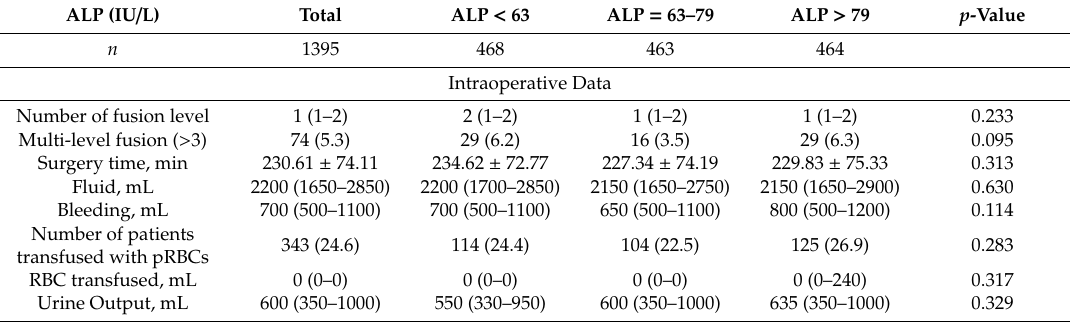
Table 2. Intergroup comparison of perioperative data based on distribution of preoperative